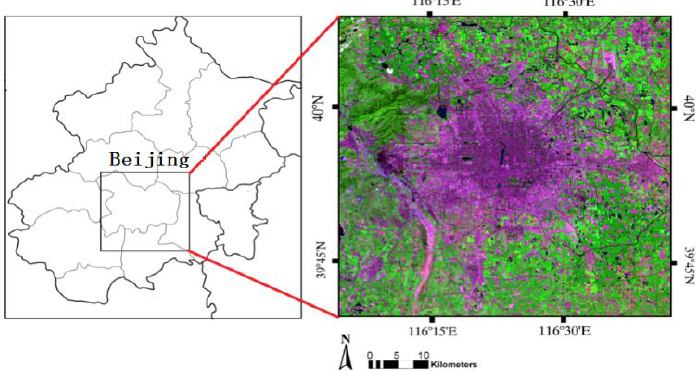
Figure 1. Study area and one Landsat image acquired on 30th Augest,2000, RGB as band 7, 4,